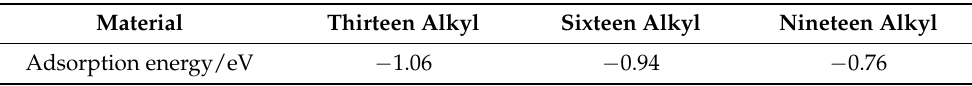
Table 3. The adsorption energy of water molecules with modified graphene